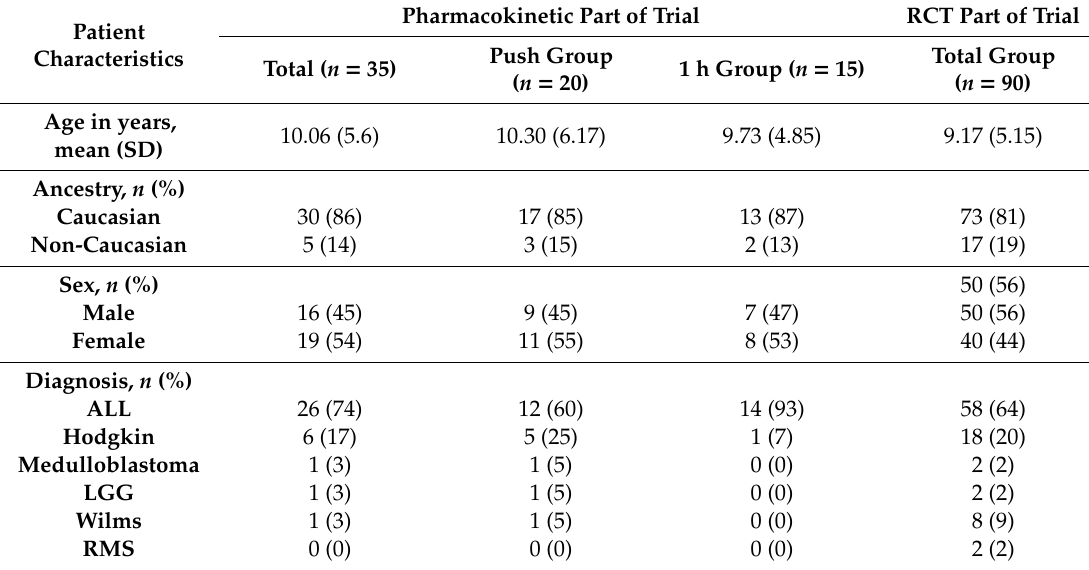
Table 1. Patient characteristics of the included